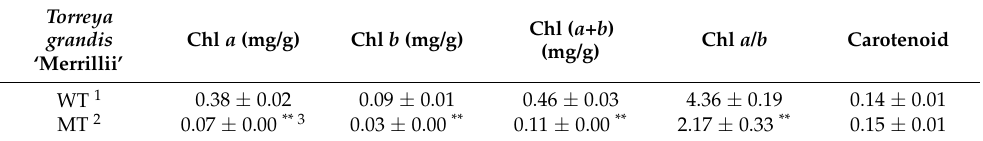
Table 1. Photosynthetic pigment contents in leaves of mutant-type and wild-type Torreya grandis ‘Merrillii’.